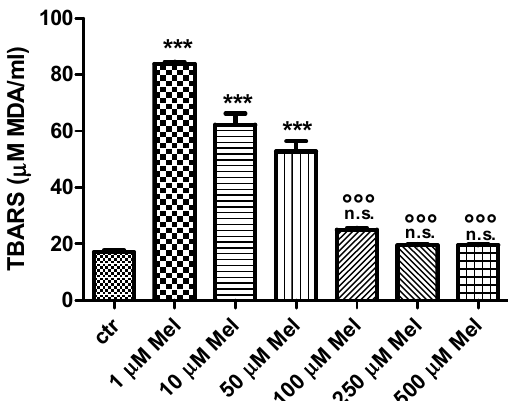
◦◦◦ p < 0.001 vs. either 1 µ M or